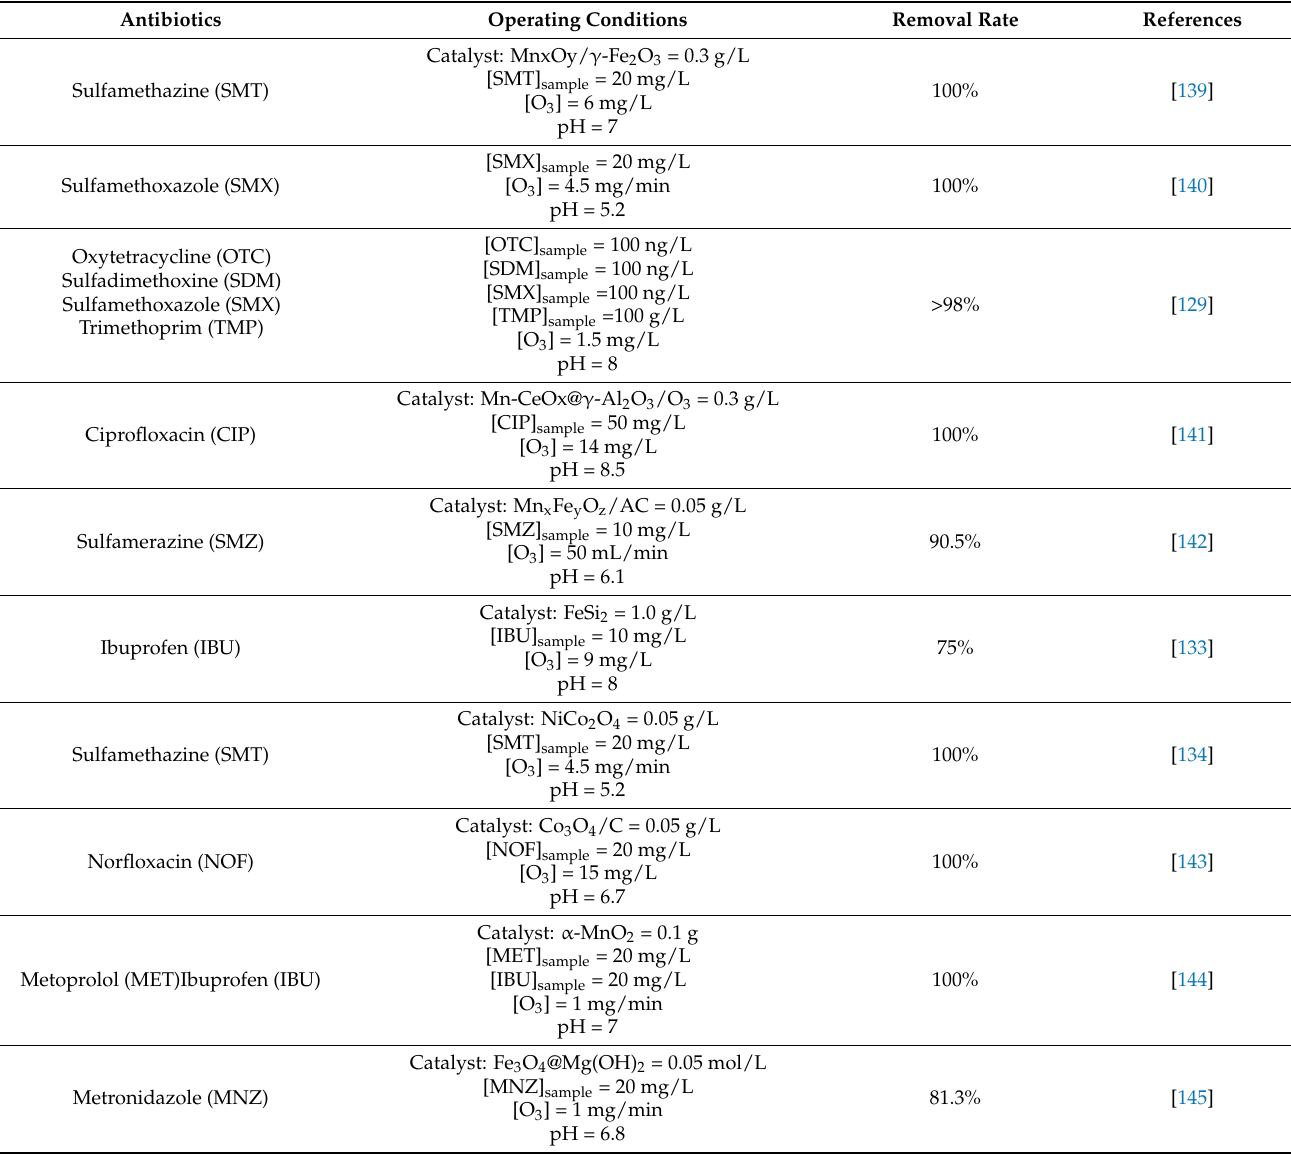
Table 5. The performance of antibiotics removal by using ozone or ozone catalytic